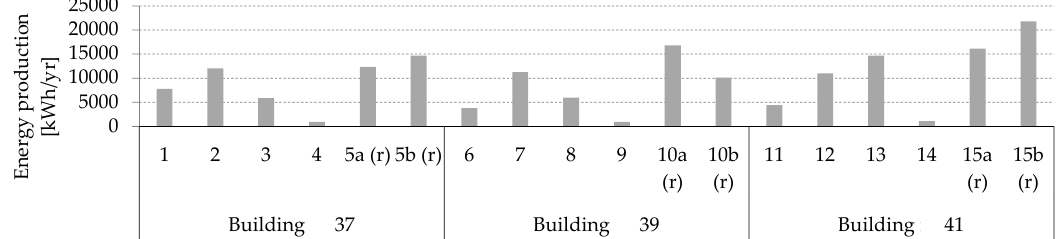
Figure 22. Solar energy generation on roofs (r) and façades in the critical area for feasibility study I.